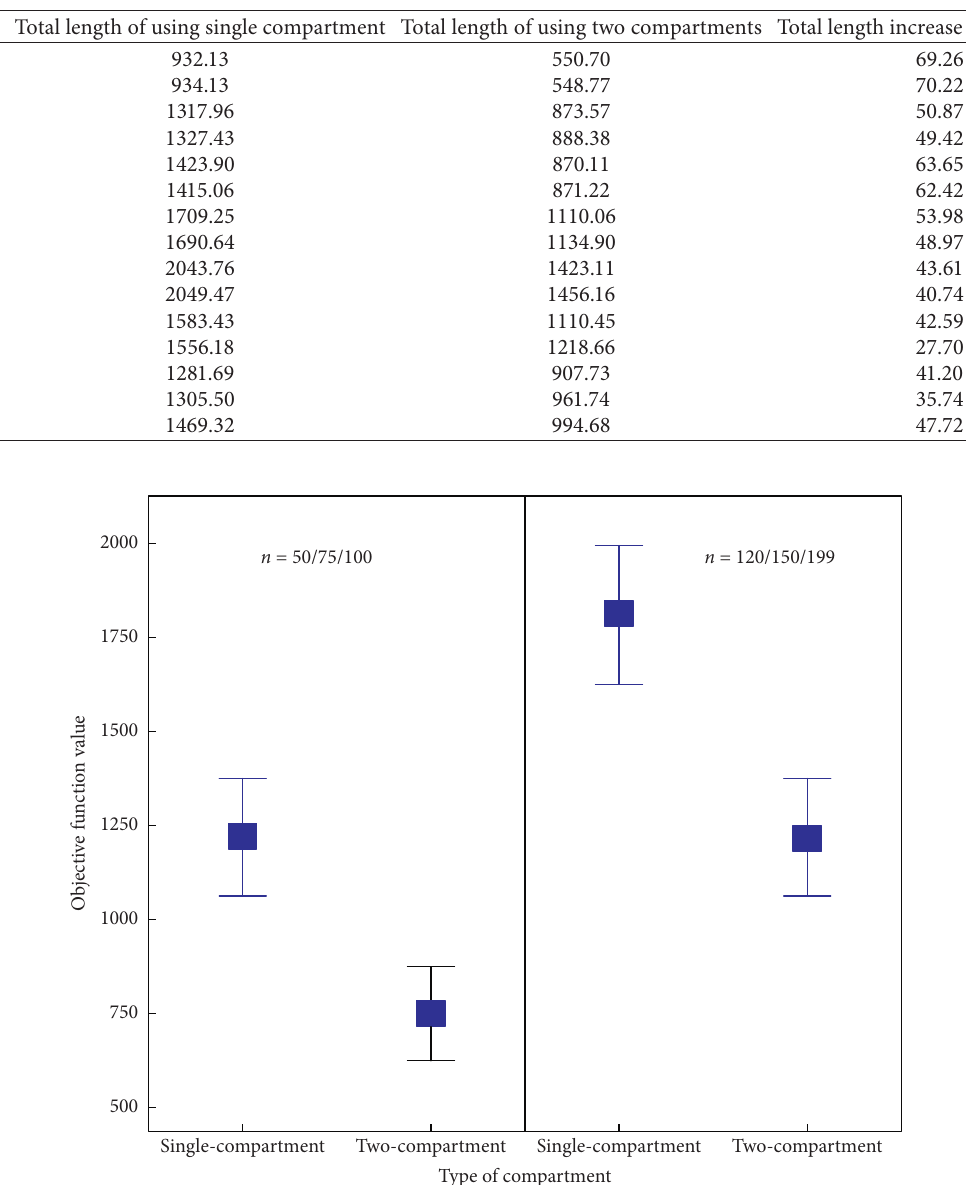
Table 4: Comparison results of using different compartment vehicles.